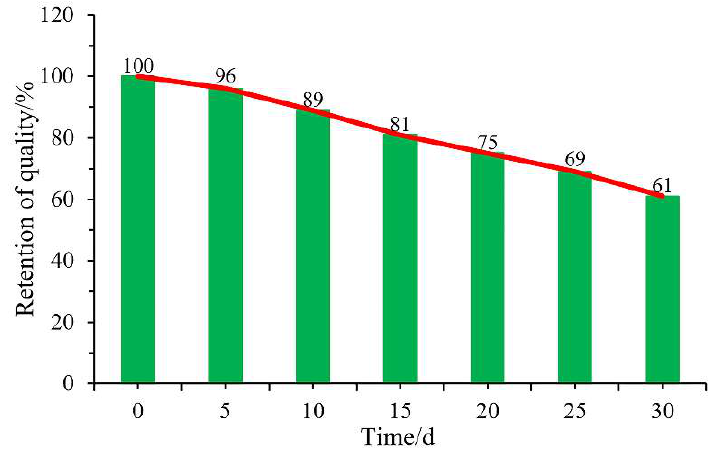
Figure 4. Degradability curve of dust suppressant film [35].